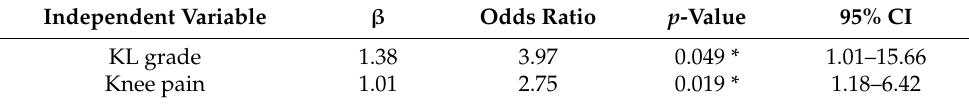
Table 2. Logistic regression model of factors correlated with undergoing